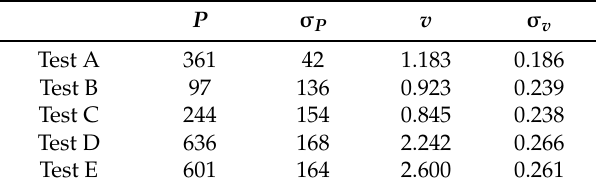
Table 1. Data from flexural tests.